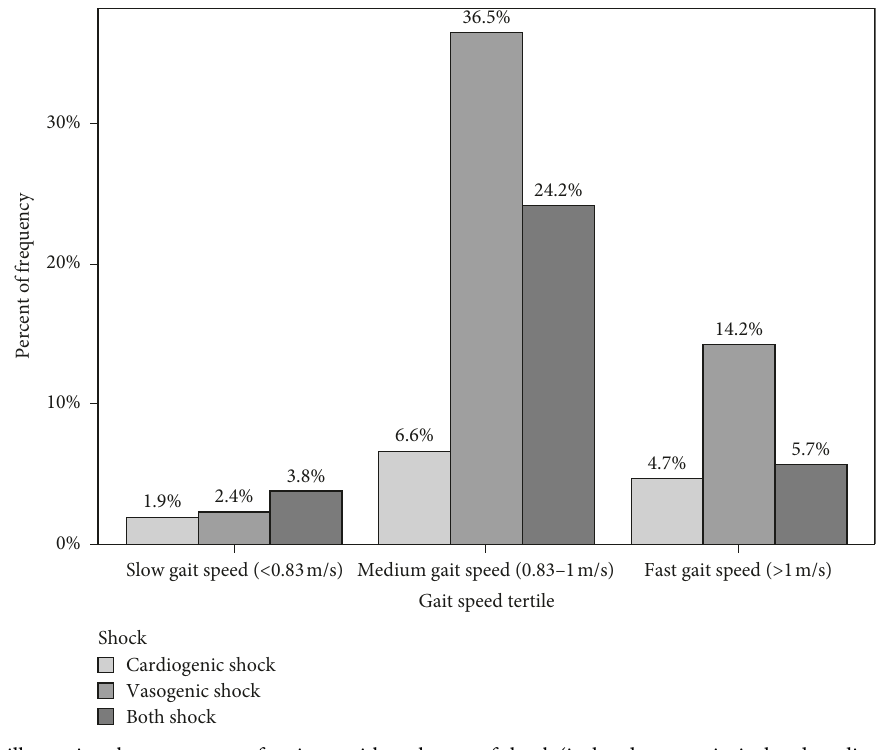
Figure 3: Bar graph illustrating the percentage of patients with each type of shock (isolated vasogenic, isolated cardiogenic, or both shocks) ( n � 211) within each gait speed tertile. Not shown are the 122 patients (40.7%) who experienced no postoperative shock. Table 2: Outcomes stratified by gait speed